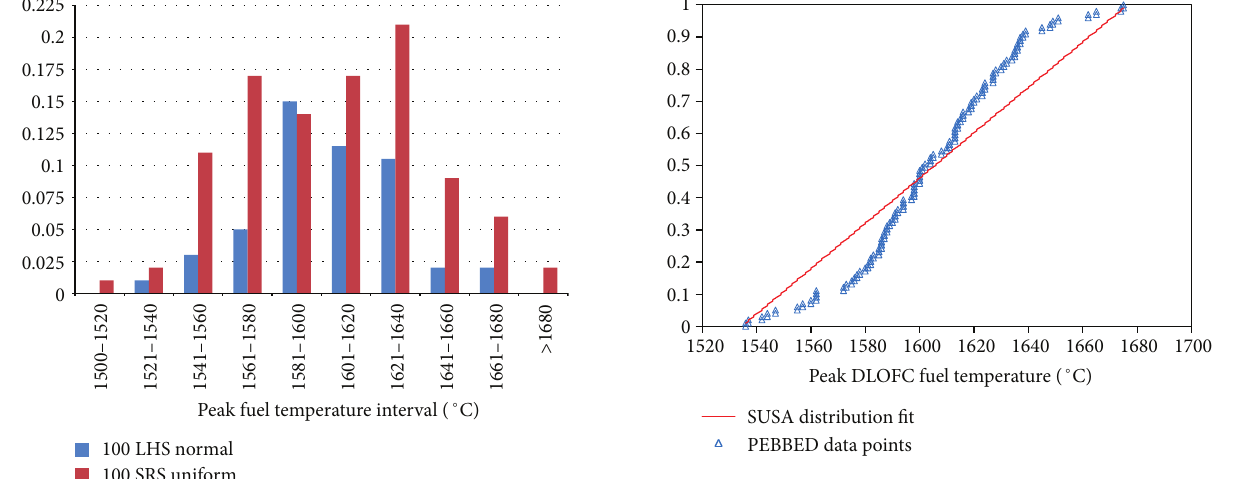
F 12: PDF and �tted uniform distribution results for the 100 LHS Normal set: �-S Level of Signi�cance � 0.002�.